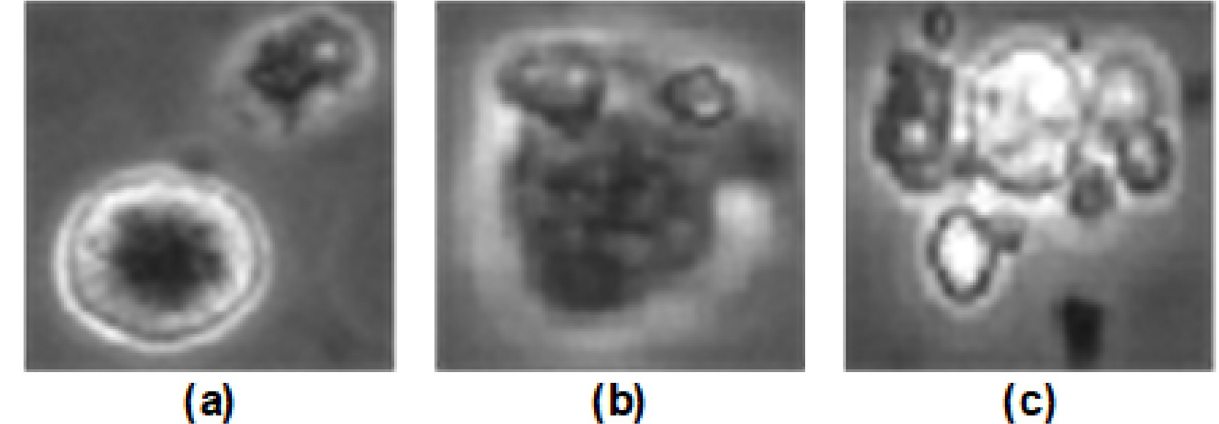
Fig 16. Examples of images that were unintentionally labeled wrong by the biologist, but correctly classified by our classifier. (a) Unattached cell mislabeled as Cell cluster , (b) Attached cell mislabeled as Dynamically Blebbing cell . (c) Apoptically Blebbing cell mislabeled as Cell cluster .